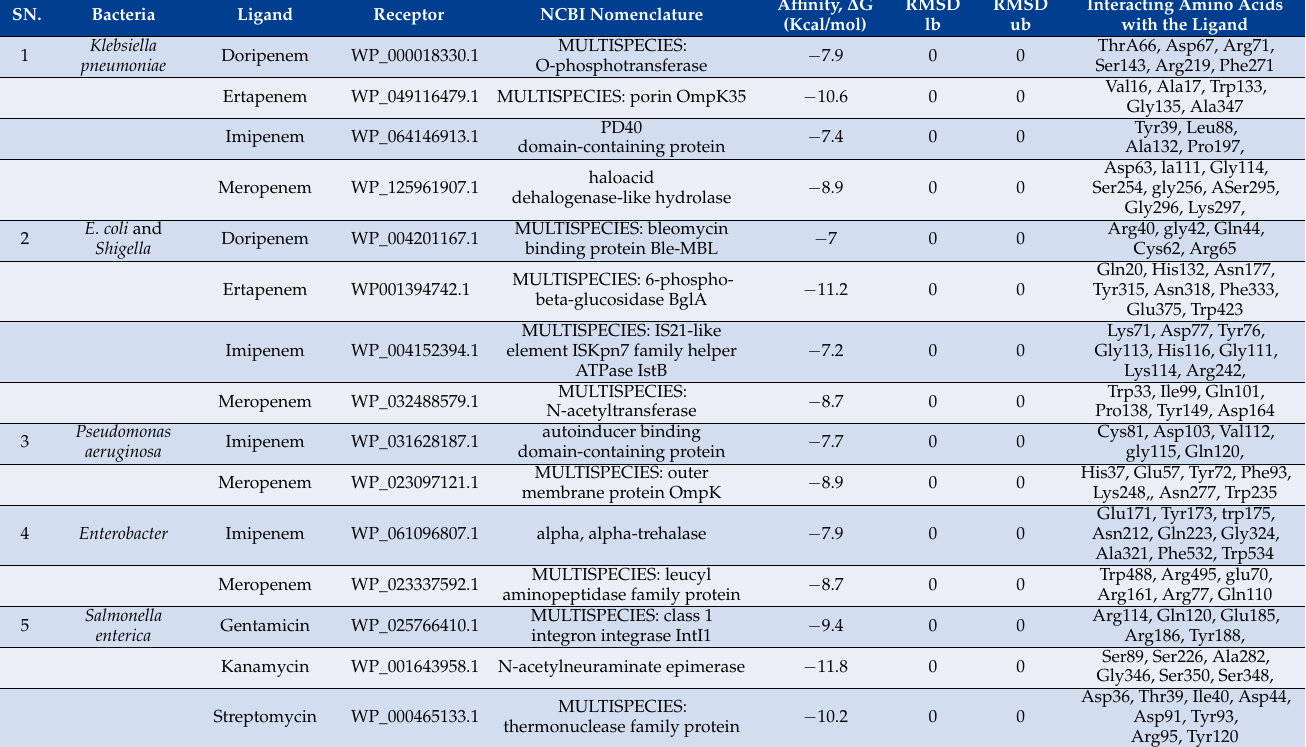
Table 3. List of novel AMR genes with their NCBI nomenclatures that were identified in this study. Each receptor–ligand interaction based on highest binding affinity is tabulated. Details regarding RMSD lower bound, RMSD upper bound, and respective interacting amino acids are also